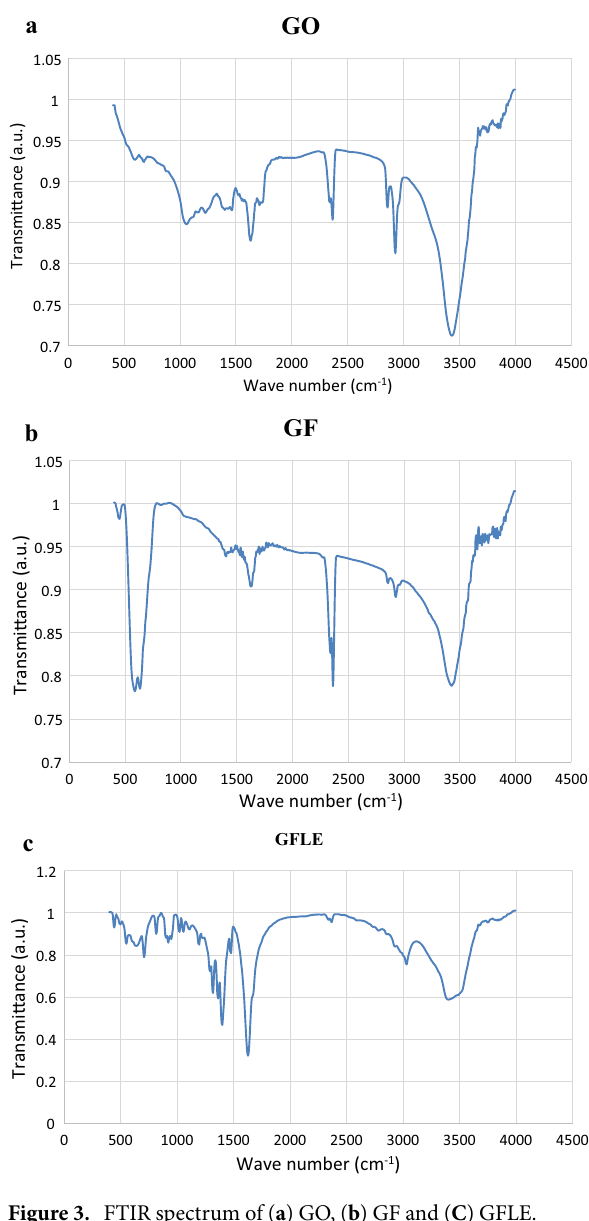
Figure 3. FTIR spectrum of ( a ) GO, ( b ) GF and ( C )